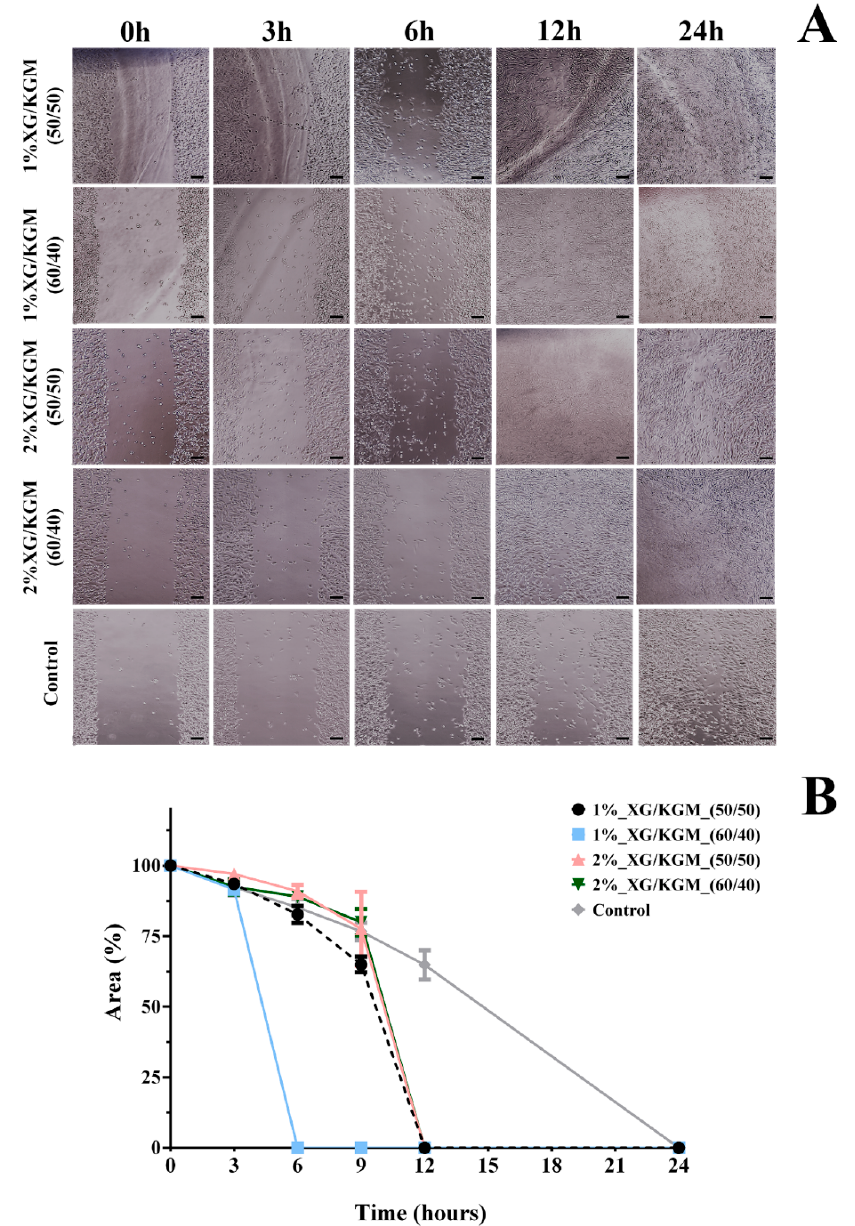
Figure 7. Cell migration response to biomaterial conditioned medium. ( A ) Fibroblast migration in the presence of hydrogels formulations and only culture medium (control). ( B ) Effect of the different hydrogels on the migratory activities of fibroblasts in the scratch assay. Data are expressed as a percentage of cell area compared to the control. Scale bar: 100 µm.